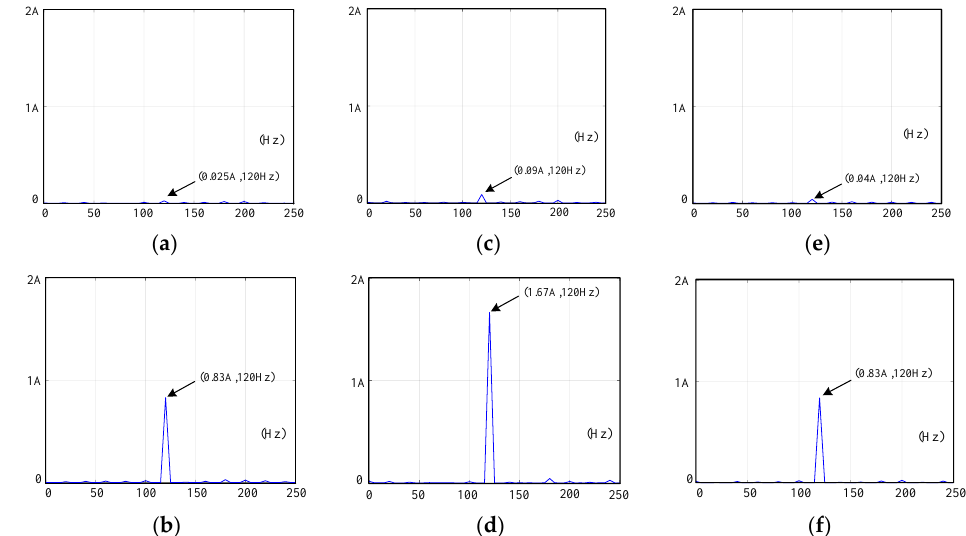
Figure 10. Close-to-120 Hz FFT results of current i CT of the DC-link capacitor under test for ( a , c , e ) balanced and ( b , d , f ) unbalanced load conditions in the ( a , b ) full-scale voltage rating VSI, ( c , d ) conventional down-scale voltage rating evaluation system, and ( e , f ) proposed down-scale voltage rating evaluation system.